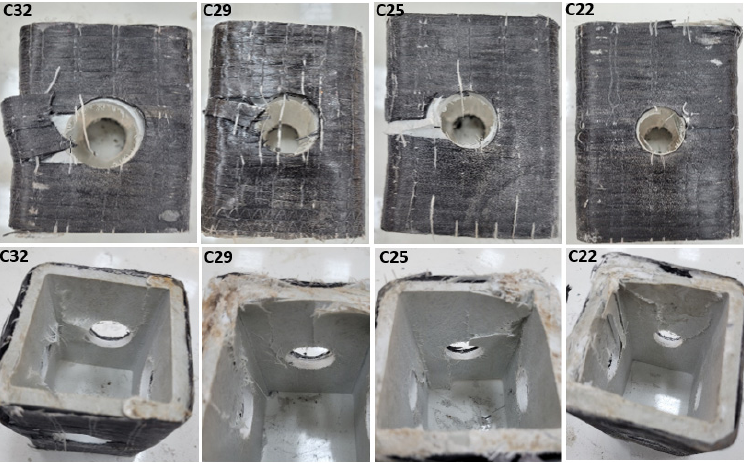
Figure 10. Damage photos of the C32, C29, C25, and C22 specimens.